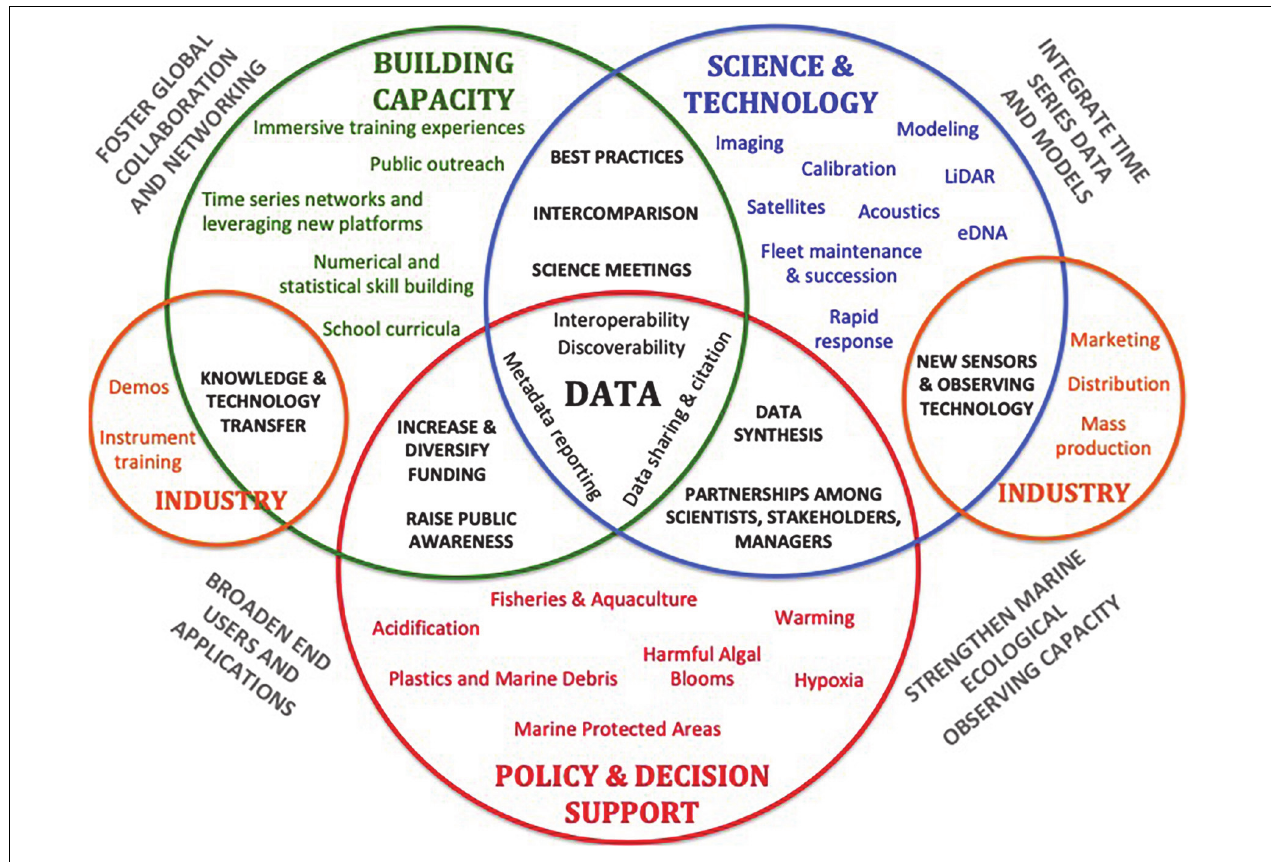
FIGURE 9 | Venn diagram illustration of proposed themes and implementation mechanisms for marine ecological time series of the